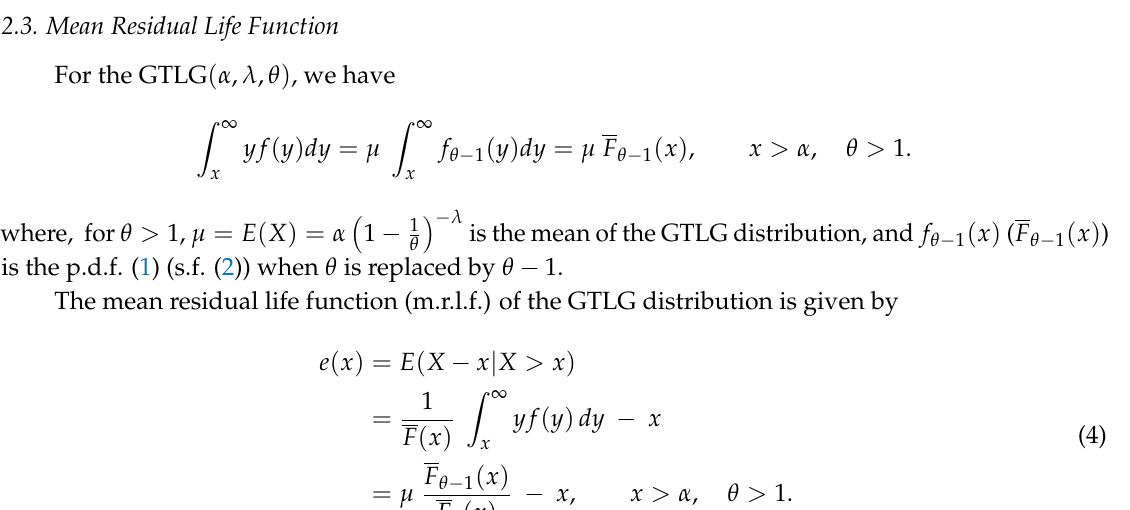
Figure 2. Hazard rate function of GTLG distribution for selected values of θ and λ when α =